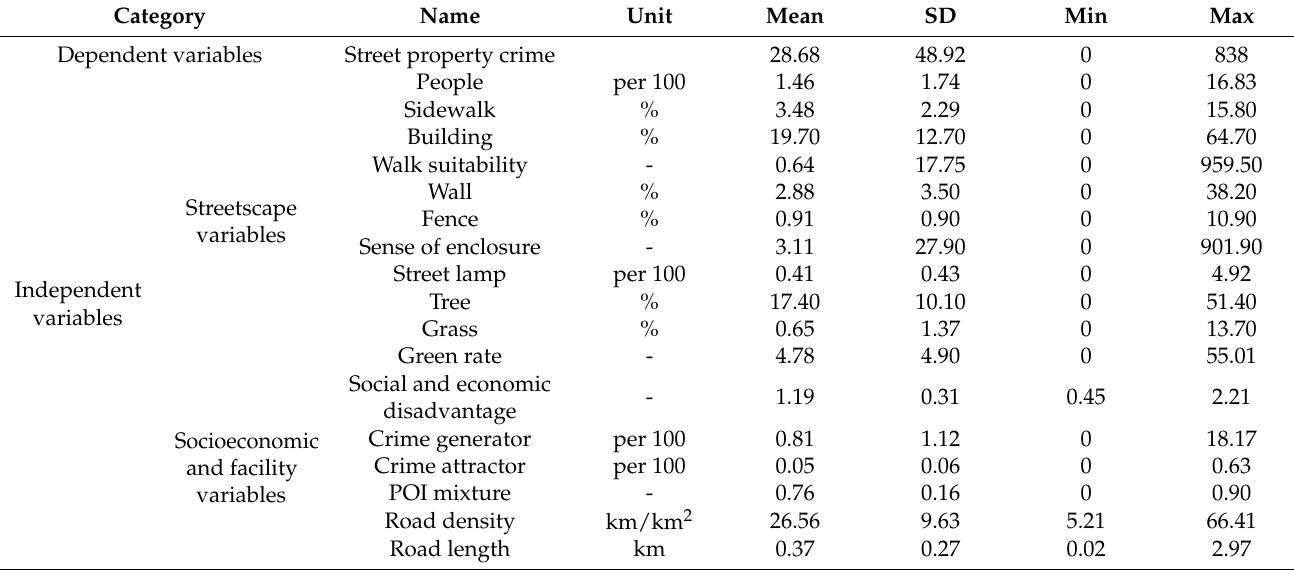
Table 1. Descriptive statistics of